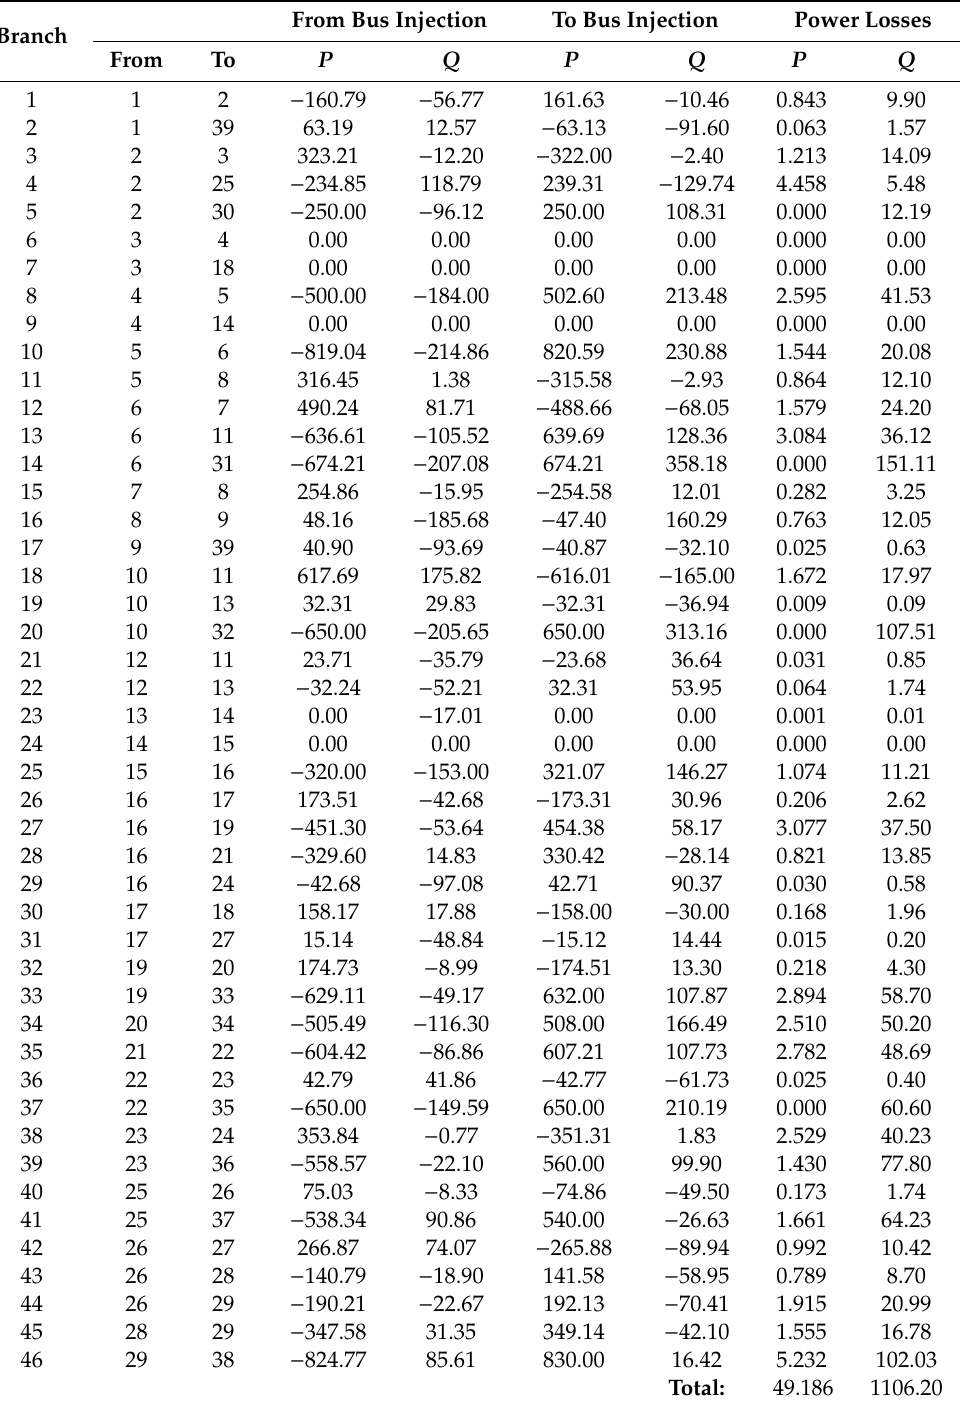
Table A45. Results of Mixed AC / DC PF calculations in Case 7-4. AC branch